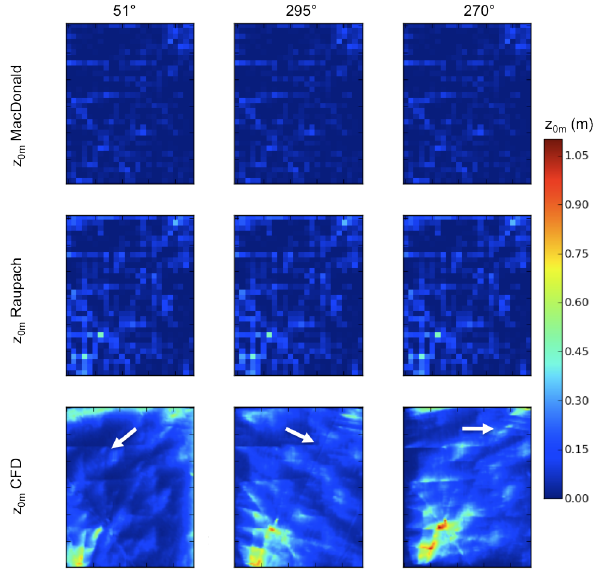
Figure 4: Roughness length maps derived from the LIDAR data over the Yingke area (7.2 482 Fig. 4. Roughness length maps derived from the LIDAR data over km 2 ) for wind flows from N-E (51°), W-NW (295°) and W (270°), presented from left to 483 the Yingke area (7.2km 2 ) for wind flows from N–E (51 ◦ ), W–NW right, and related results following the approaches from MacDonald, Raupach, and from the 484 (295 ◦ ) and W (270 ◦ ), presented from left to right, and related results CFD, from top to bottom. Arrows represent wind directions accounted in both geometrical 485 following the approaches from MacDonald, Raupach, and from the and CFD based calculations. 486 CFD, from top to bottom. Arrows represent wind directions ac- counted in both geometrical and CFD based calculations.